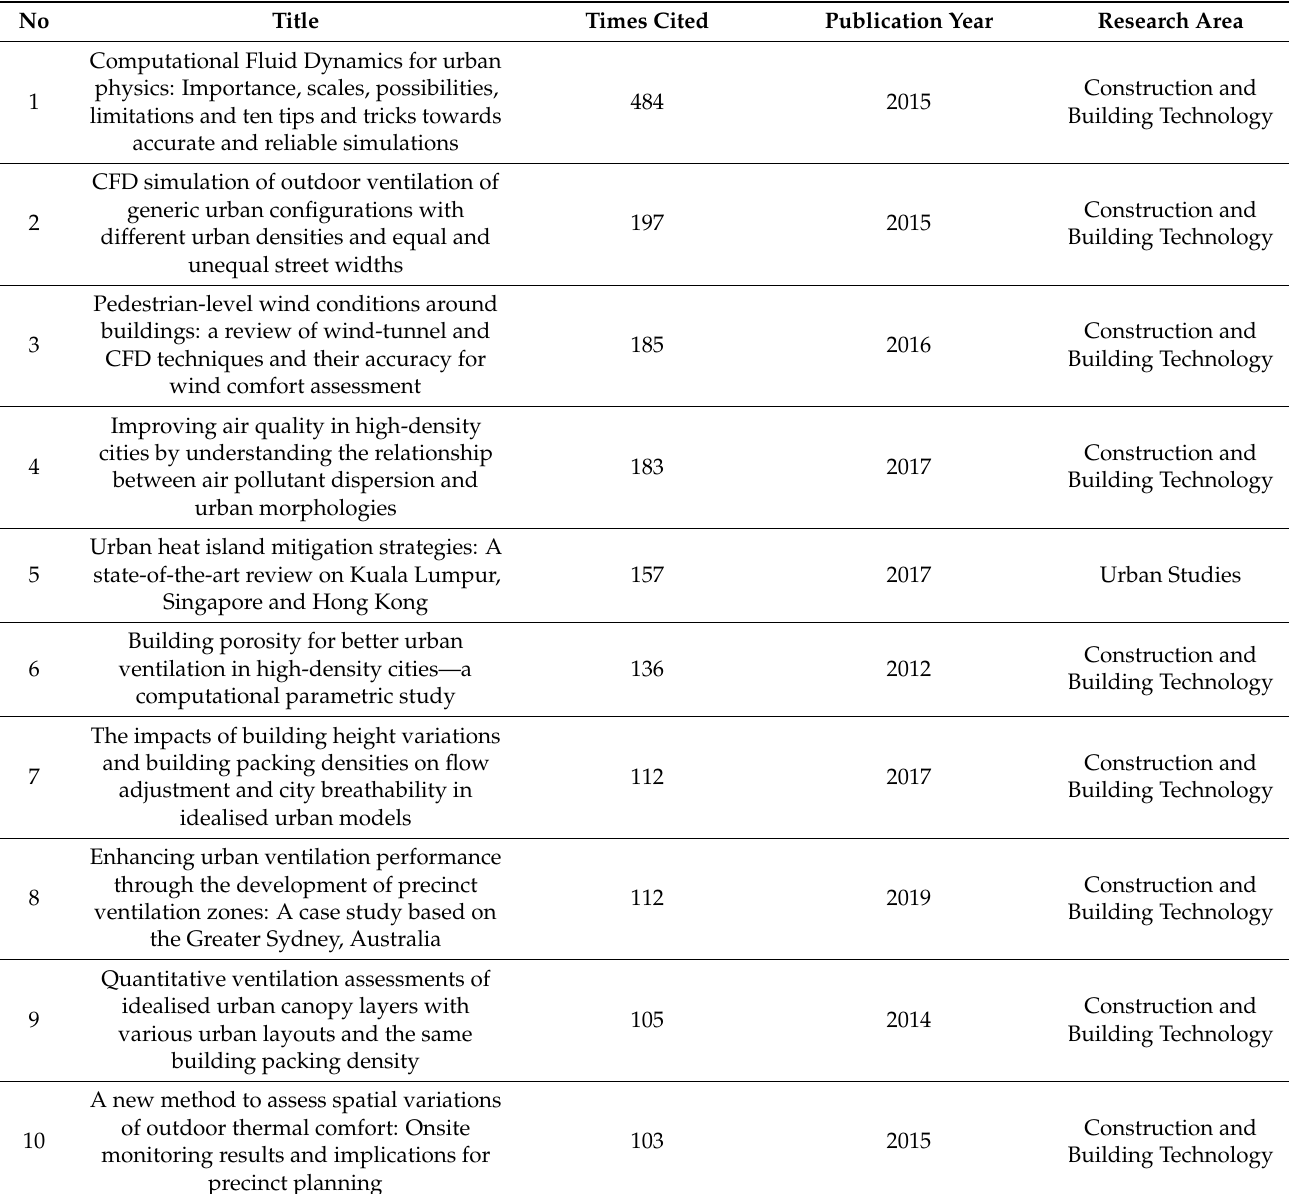
Table 7. Most-cited articles on high-density city research from 2001 to